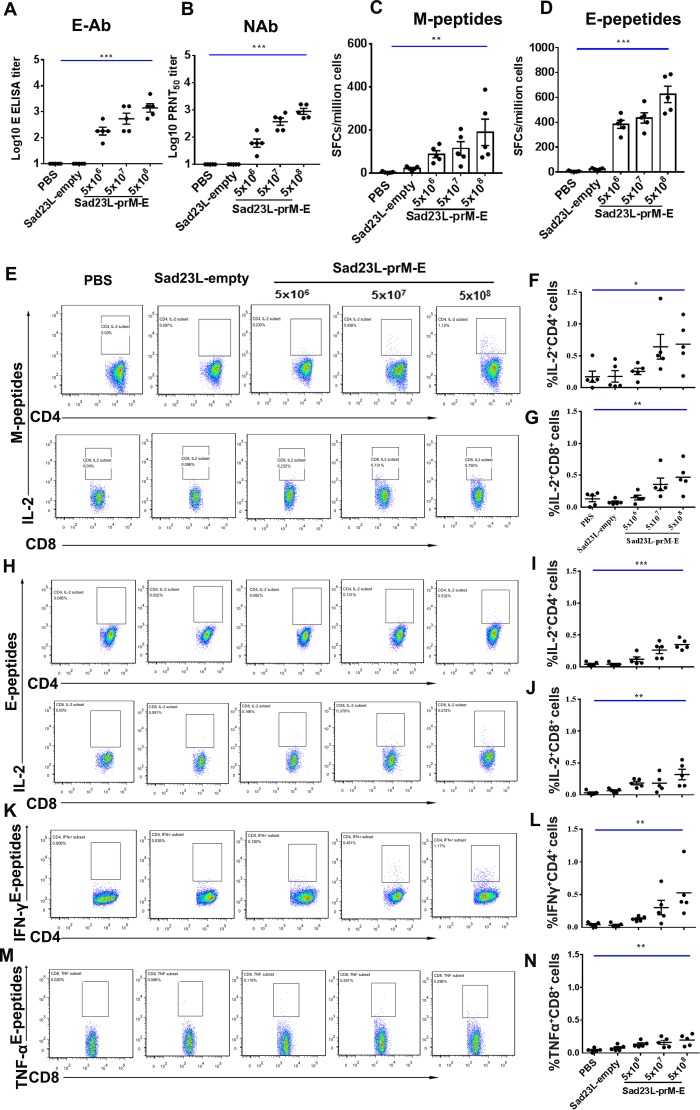
Humoral and cellular immune dose response of Sad23L-prM-E vaccine to mice.C57BL/6 mice were immunized by a single dose of 5×106, 107 or 108 PFU Sad23L-prM-E vaccine, Sad23L-empty or PBS control, respectively. Sera and splenocytes were collected from vaccinated mice for measurement of antibody and T cell responses at 4 weeks post-immunization. (A) E-Ab titer was measured by ELISA. (B) NAb titer was measured by PRNT50. (C and D) The number of specific IFN-γ spot forming cells (SFCs) per million splenocytes to M or E peptides was measured by ELISpot, respectively. (E-G) Intracellular IL-2+ CD3+CD4+ and IL-2+ CD3+CD8+ cells to M peptides were detected by ICS. (H-N) Intracellular IL-2+ CD3+CD4+, IL-2+ CD3+CD8+, IFN-γ+ CD3+CD4+ and TNF-α+ CD3+CD8+ T cells to E peptides were detected by ICS, respectively. Data are shown as mean ± SEM (standard errors of means). P values are analyzed by one-way ANOVA. Statistically significant differences are shown with asterisks (*, P<0.05; **, P< 0.01 and ***, P< 0.001); ns, no significant difference; PRNT50, 50% plaque reduction neutralization test.